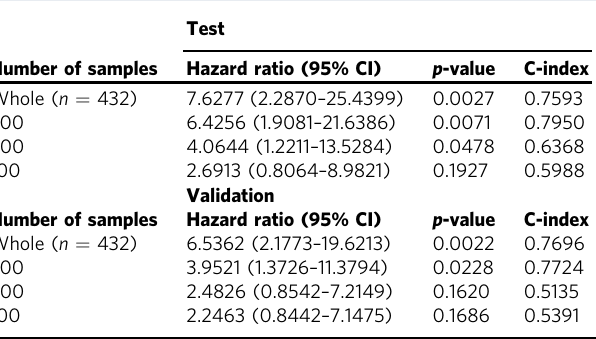
Table 5 Performance of DL (Yolo) risk model with respect to the different number of training samples for the training and validation